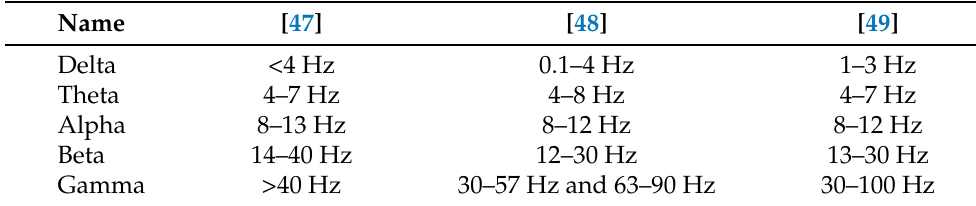
Table 2. Examples for EEG frequency band